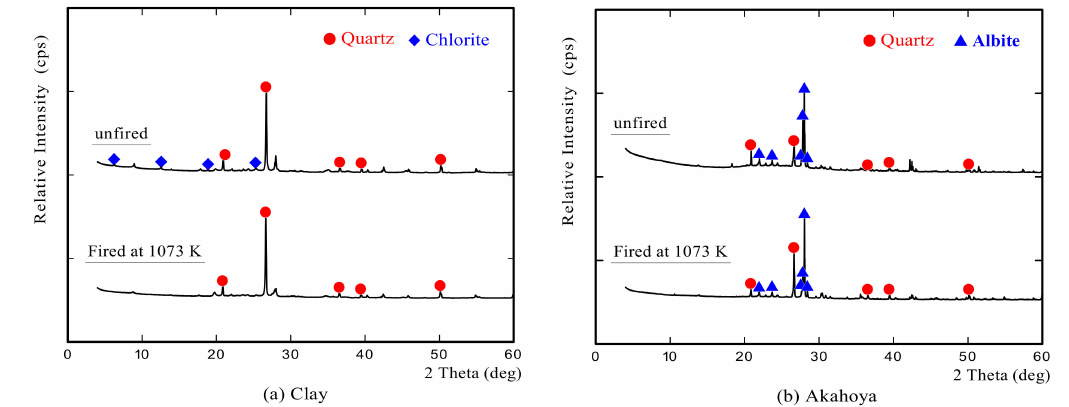
Figure 7. X-ray diffraction profiles of ( a ) clay and ( b ) Akahoya.